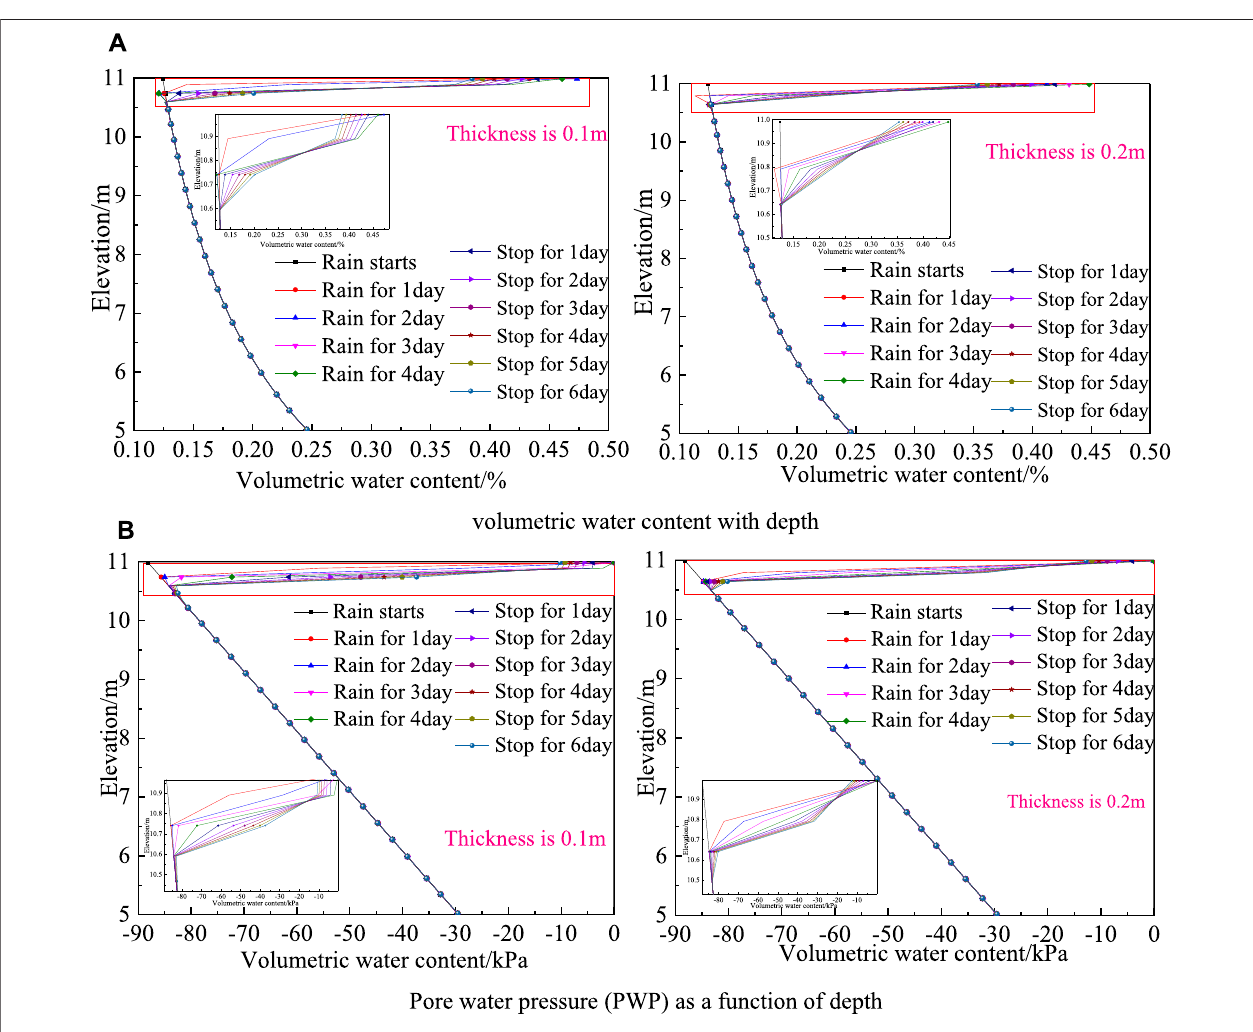
FIGURE 16 | Behaviour of volumetric moisture content and PWP with depth at cross-section A. (A) volumetric water content with depth. (B) Pore water pressure (PWP) as a function of depth